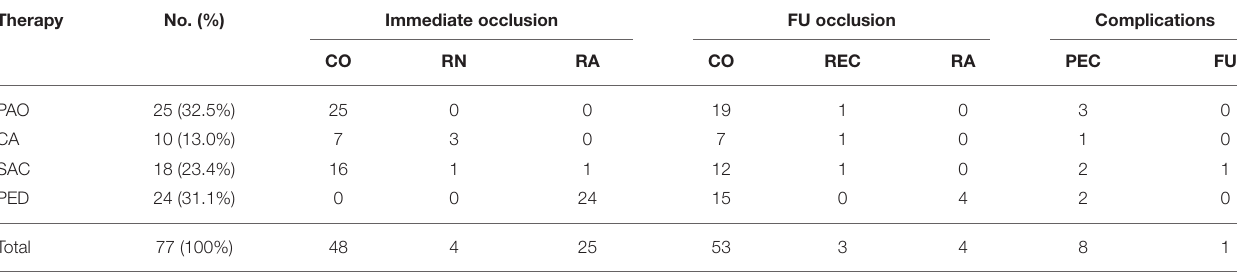
TABLE 2 | Aneurysm occlusion and complications of endovascular treatment.